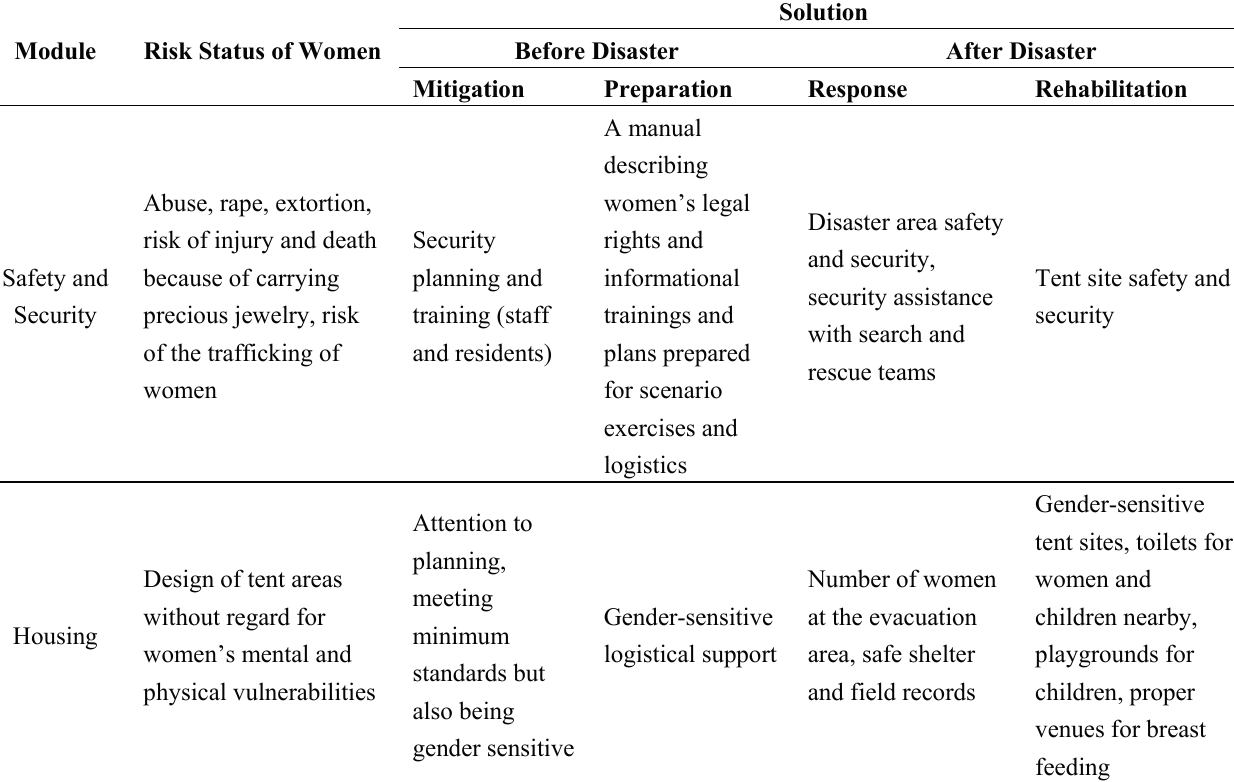
Table 2. Modules that should be included in emergency action plans: risk status of women during disasters and solutions during different phases of the disaster management